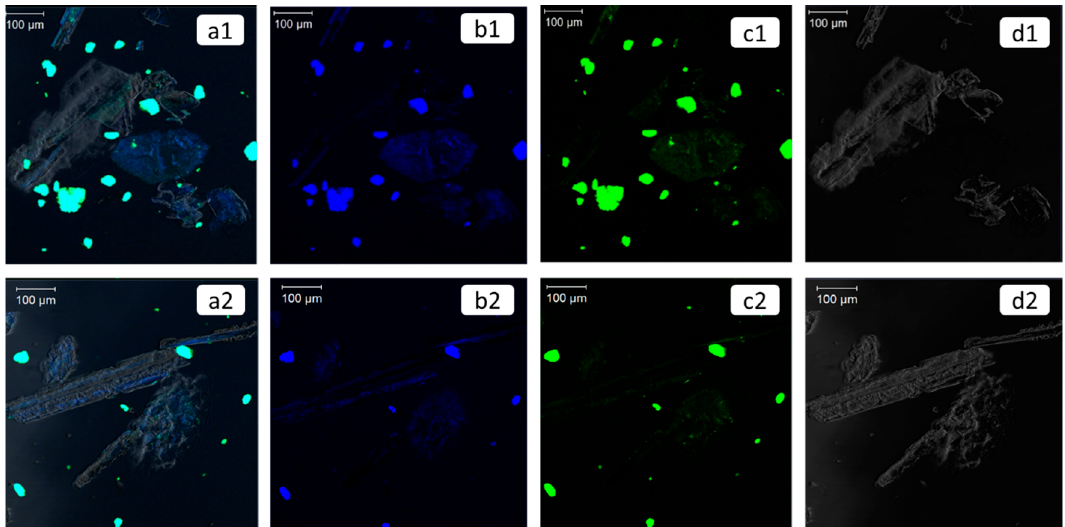
Figure 8. Fluorescent images of the liquid phase of a gypsum solution with 10 mg·dm − 3 PAA- F2/HEDP-F blend (1:1 mass) after 24 h thermal treatment (NACE Standard), obtained by a superposition of three channels detection modes (HEDP-F—blue, PAA-F2—green, and transmitted laser light—grey) taken at different points ( a – d ). Scale marker corresponds to 100 µm.